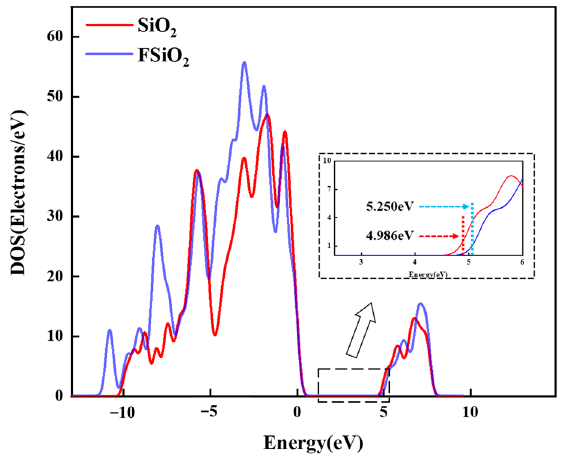
Figure 7. DOS diagram of SiO 2 before and after fluorination.